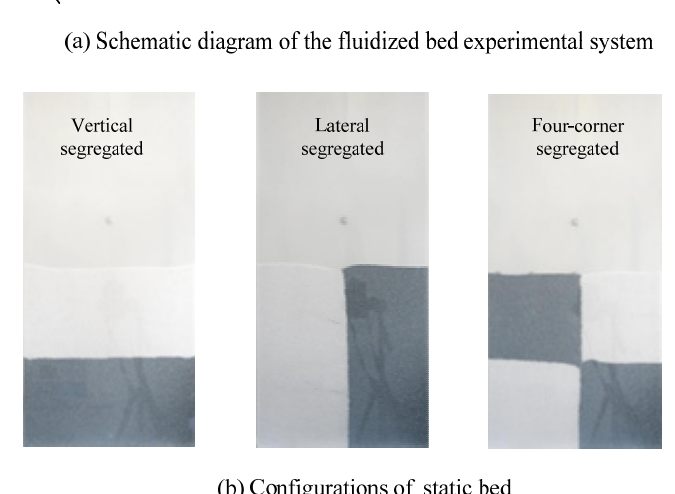
upon dense particles at the right side, which forms a four-corner segregated static bed.